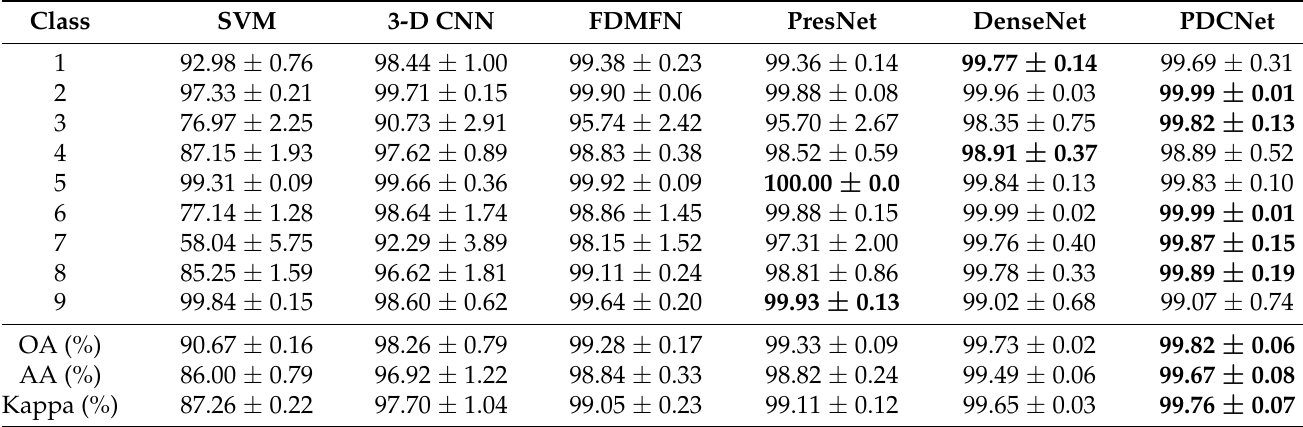
Table 9. The classification results for the UP dataset based on 5% training samples. The best results are highlighted in bold